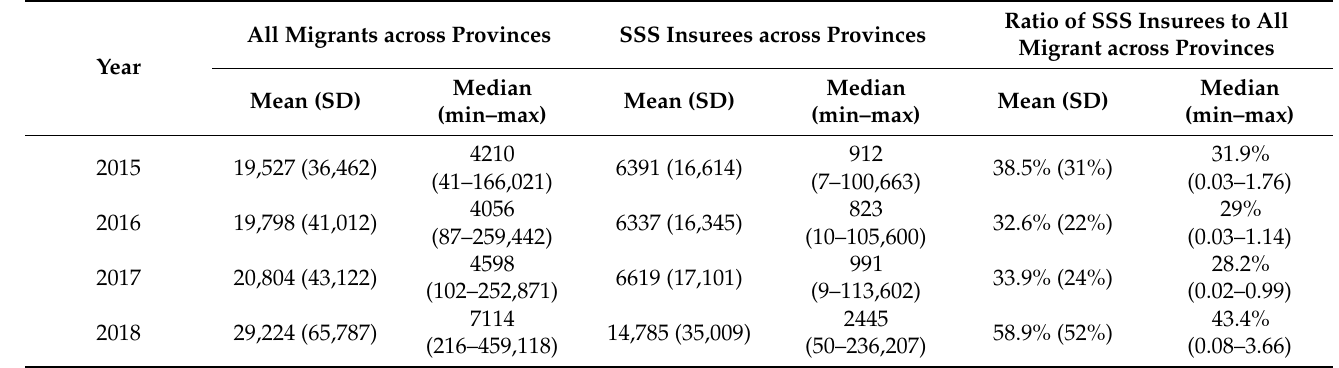
Table 1. Number of all migrants, number of SSS migrants, and the coverage of SSS to all migrants across all provinces in Thailand during 2015–2018.